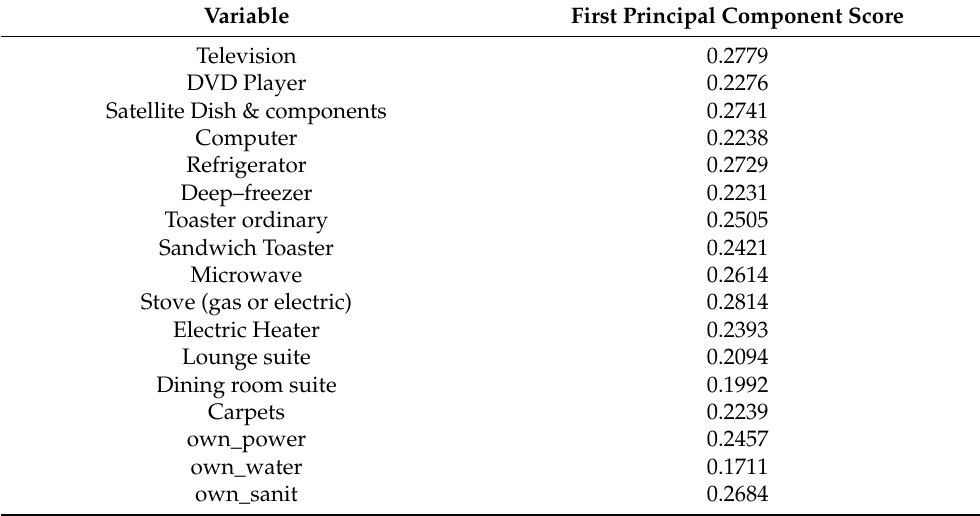
Table A8. Asset index for Zimbabwe—Results from tetrachoric Principal Components